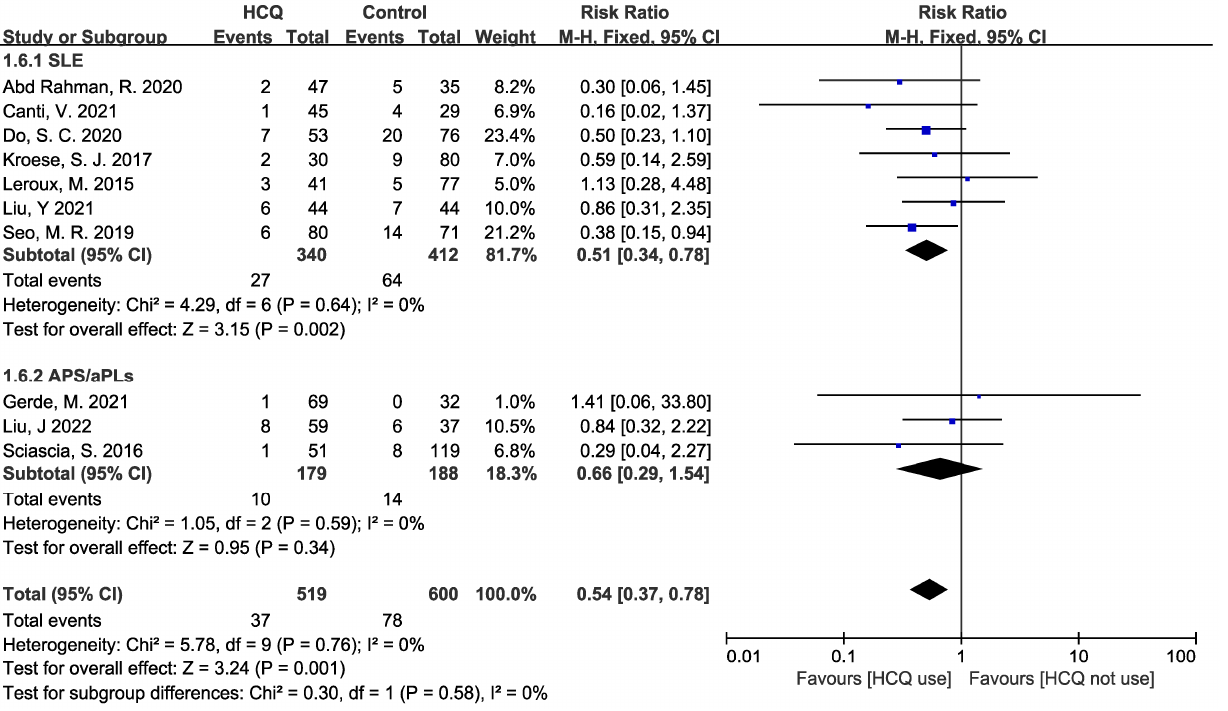
Figure 4. Forest plot for the RR of preeclampsia. The pooled estimate of the RR of preeclampsia was determined for patients taking HCQ compared to those not taking HCQ. A subgroup analysis was conducted based on the study